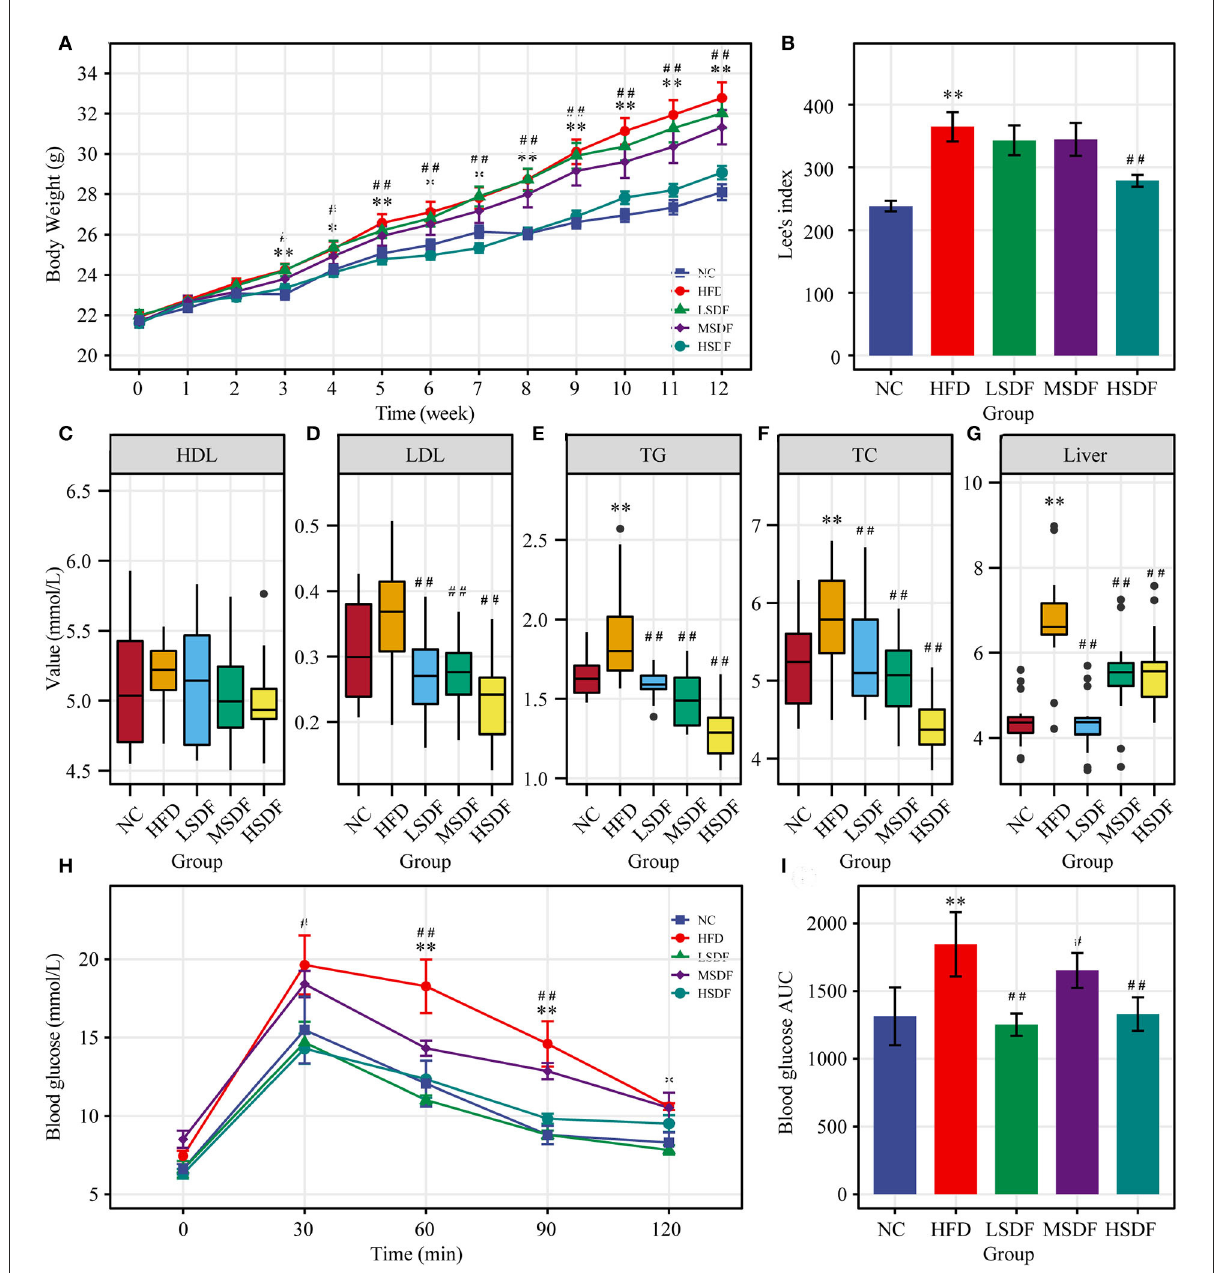
FIGURE1 Effect of PP-SDF administration on metabolic disorders in obese mice induced by a high-fat diet. (A) Time-course of body weight. (B) Obesity index of different groups. (C) Serum high-density lipoprotein (HDL). (D) Serum low-density lipoprotein (LDL). (E) Serum triglyceride (TG). (F) Serum total cholesterol (TC). (G) Liver triglycerides. (H) Curve of OGTT. (I) ATU of OGTT. NC: 10% fed on a low-fat diet, oral administration with an equivalent volume of 0.9% physiological saline; HFD: 60% fed on a high-fat diet, oral administration with an equivalent volume of 0.9% physiological saline; LDF, MSDF, and HSDF: 60% fed on a high-fat diet, different concentrations of SDF solution were gavaged: 1g/kg · BW, 3 g/kg · BW, and 5 g/kg · BW, respectively. Values were presented as mean ± SE ( n = 16). The high-fat group was compared with the blank control group, which was represented by *. The dose group was compared with the high-fat group, denoted by ## ,* p < 0.05; ## ,** p < 0.01.